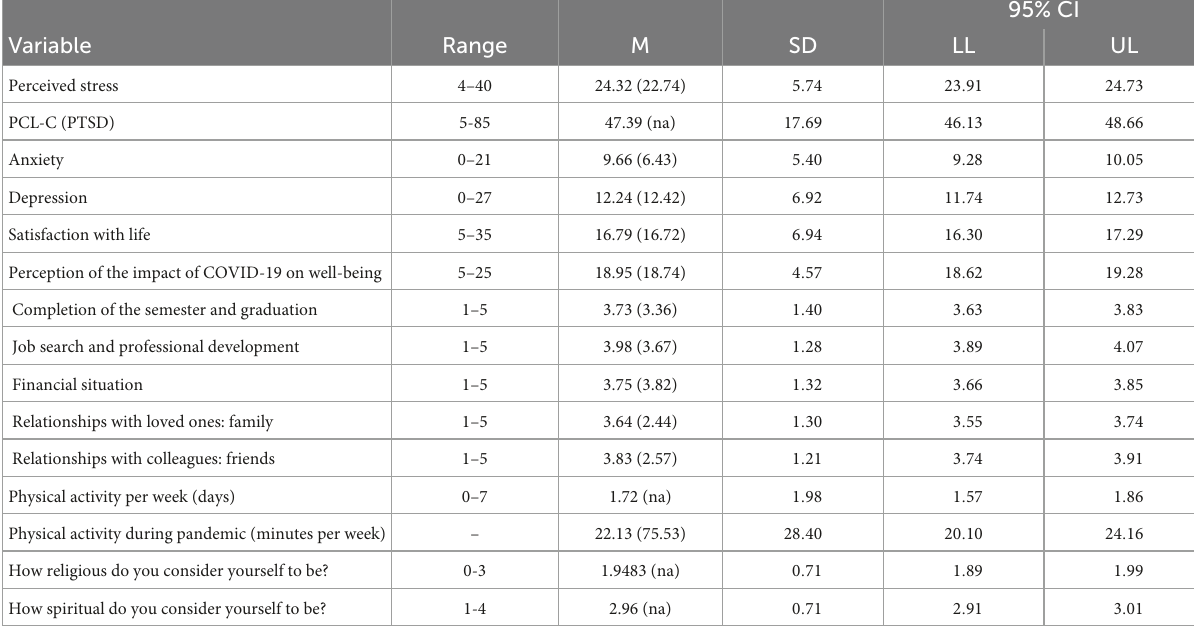
TABLE 2 Descriptive statistics ( n =